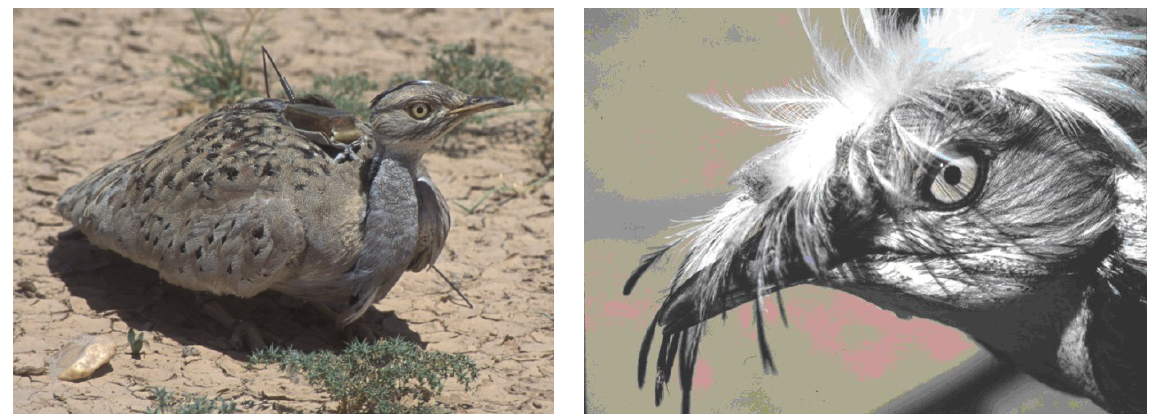
Figure 1. Asian Houbara Bustard ( Chlamydotis undulata macqueenii